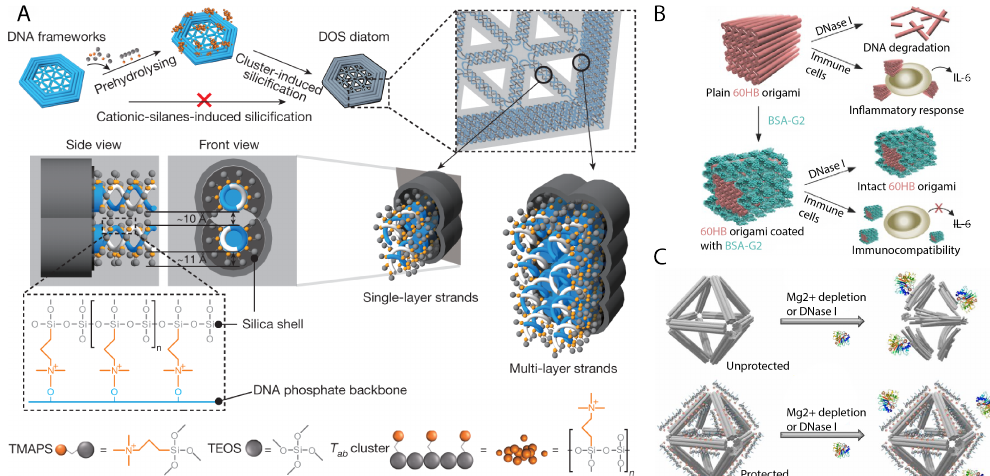
Figure 5. Reinforcement of DNA nanostructures via coating. ( A ) Applying a coat of silica on DNA nanostructures has been shown to increase stiffness and stability (reprinted with permission from Springer Nature [80]); ( B ) Protein coatings have been shown to increase immunocompatibility of DNA nanostructures as well as resist degradation by DNase I (reprinted with permission from Wiley-VCH [86]); ( C ) Peptoid coatings maintain stability of DNA nanostructures in low Mg 2 + concentrations and in the presence of DNase I (reprinted with permission from National Academy of Sciences